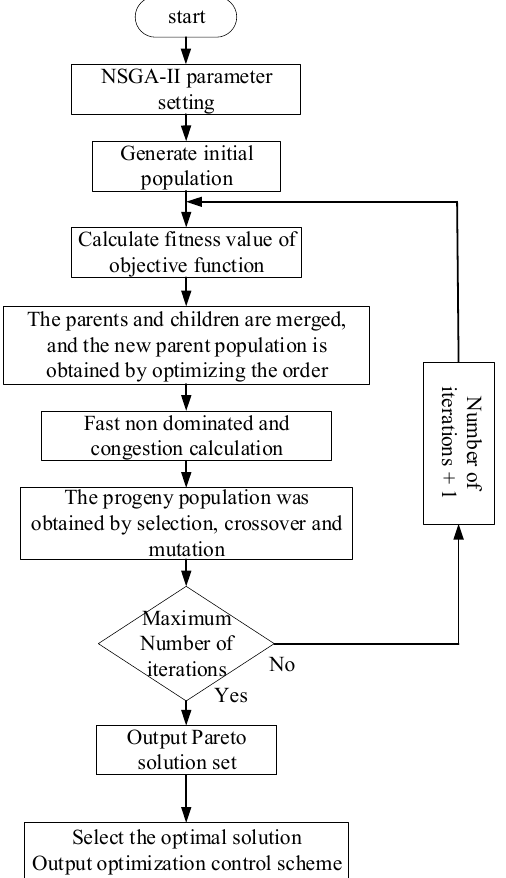
Figure 3. Solution flow of closing angle control model based on NSGA-II.